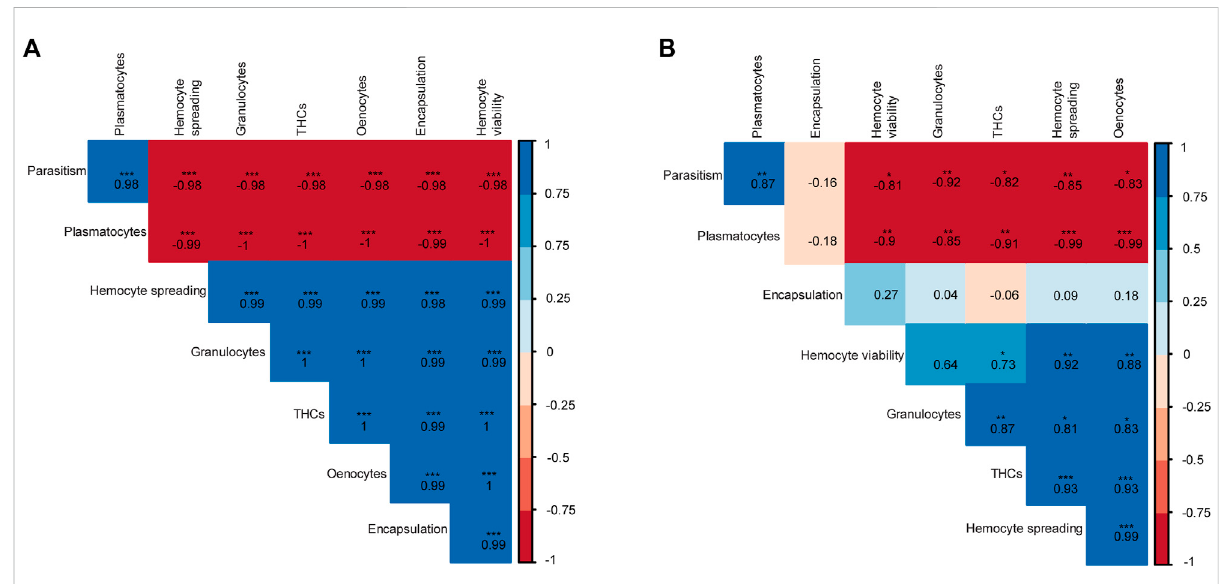
FIGURE 11 Correlogramsshowingtherelationshipsbetweenthedifferenthost-parasitoidresponsephenotypesof (A) B.dorsalis and (B) C.cosyra exposed to D. longicaudata and P. cosyra e. Asterisks represent signi fi cant correlations (*** for p < 0.001, ** for p < 0.01, and * for p < 0.05). The numbers in each box indicate the Pearson correlation coef fi cients (r) for the respective pair of parameters